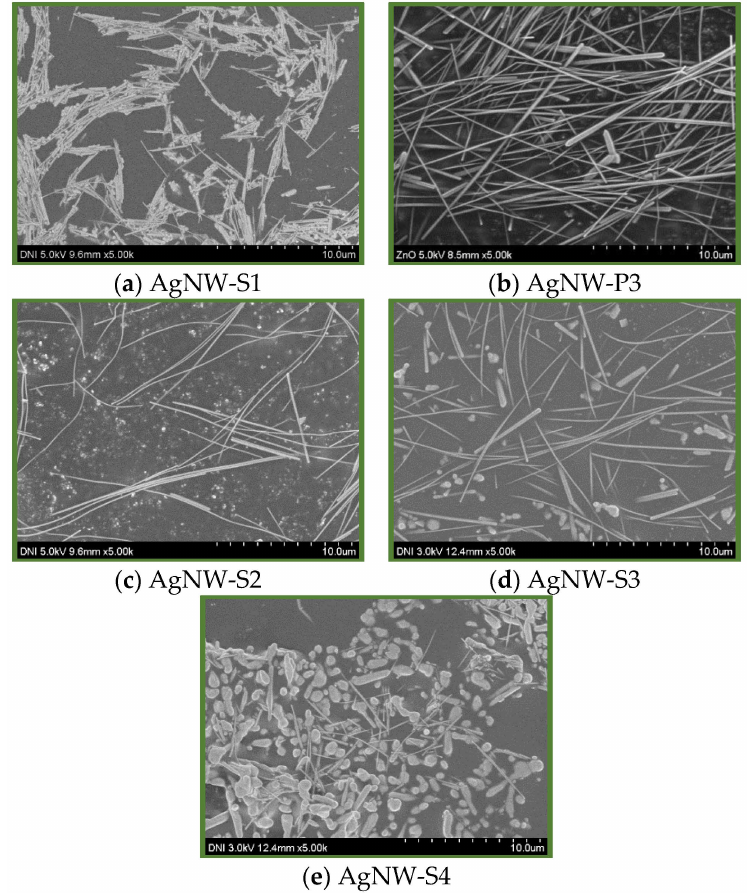
Figure 2. SEM images of AgNWs synthesized by varying the amount of SDS, ( a ) 0.24; ( b ) 0.30; ( c ) 0.36; ( d ) 0.42; and ( e ) 0.48